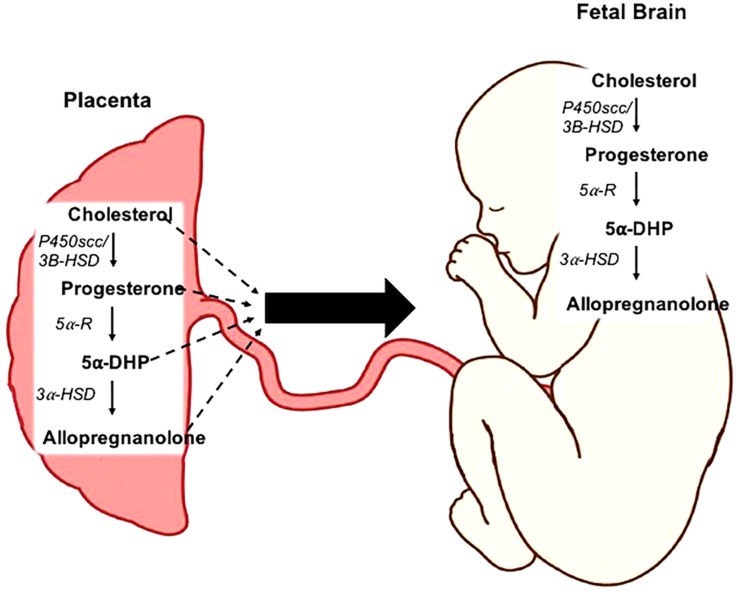
Neurosteroidogenesis in the placenta and fetal brain. Cholesterol is metabolized into progesterone by the enzymes cholesterol side-chain cleavage (P450scc) and 3β-hydroxysteroid dehydrogenase (3β-HSD). The rate-limiting enzymes 5α-reductase type 1 and 2 (5α-R) facilitate the conversion of progesterone into 5α-dihydroprogesterone (5α-DHP). Allopregnanolone is then synthesized from this precursor by 3α-hydroxysteroid dehydrogenase (3α-HSD). This process can occur both within the placenta, and de novo within the fetal brain.